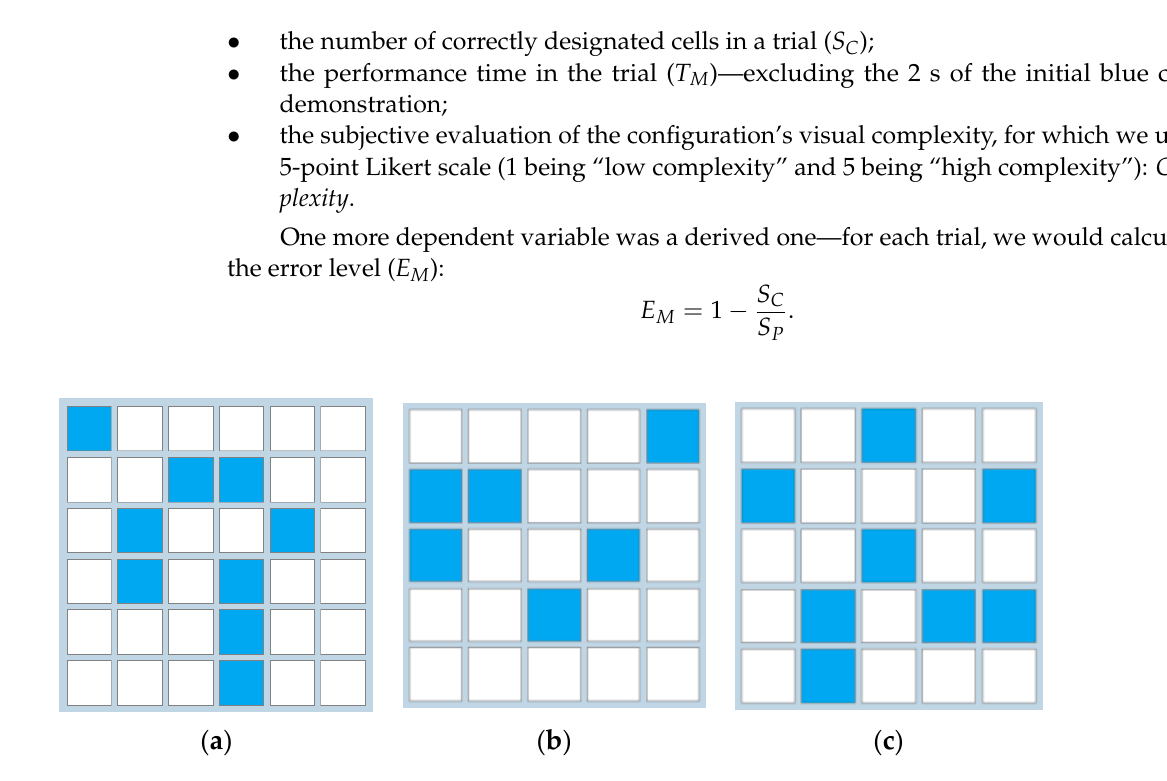
Figure 6. Examples of the grid configuration with the numerical values corresponding to the cells.